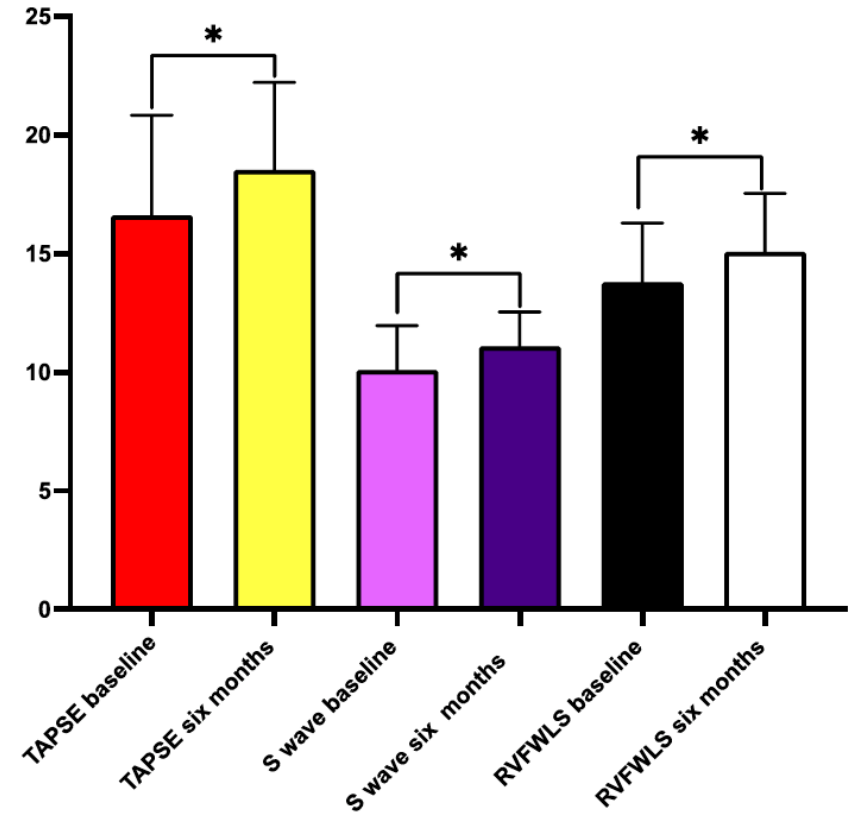
Figure 2. Effects of CCM therapy of right ventricular contractility indexes. * = p < 0.05.